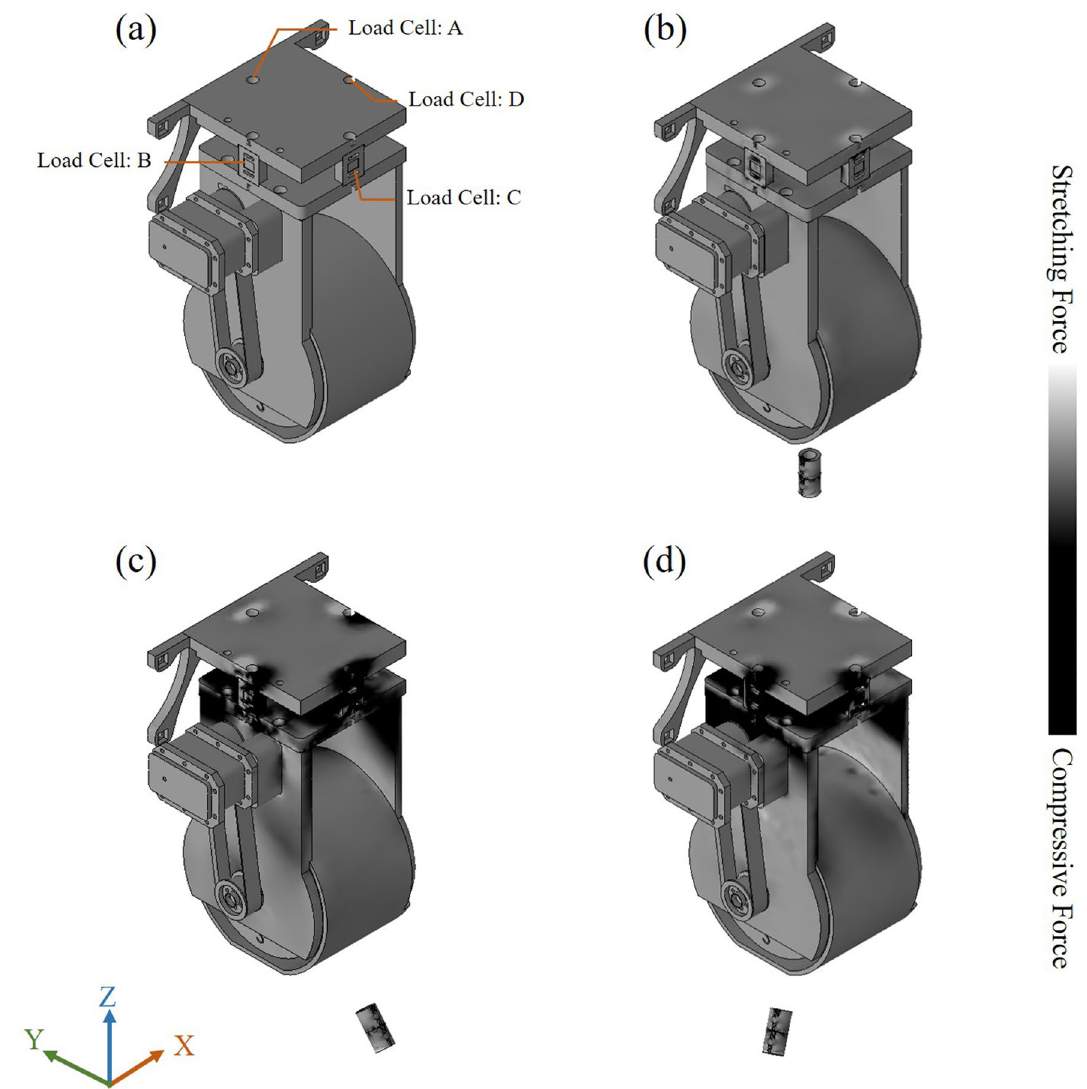
Figure 6. Heat maps showing forces in various locations around an IPM. ( a ) Without magnetic objects; ( b ) IPM directly beneath the EPM; ( c ) IPM is in front of the EPM. Load cell A is stretched while load cell C is squeezed; ( d ) IPM is located in the bottom right region of the EPM. Load cells A and D are stretched while load cells B and C are